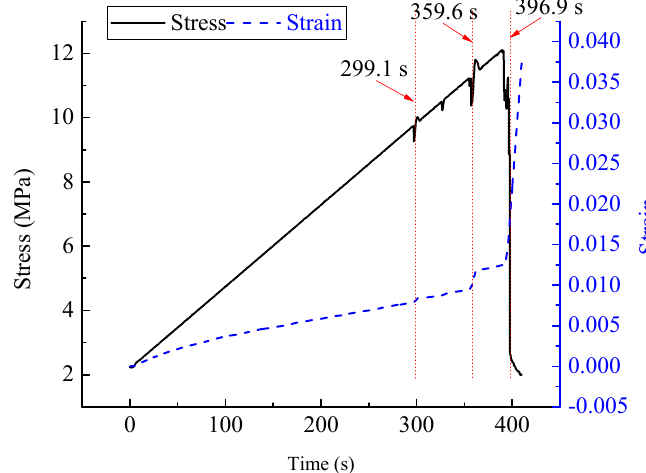
Figure 5. Curves of stress and stain with respect to loading time. The red dotted lines indicate the mutation time of curves.